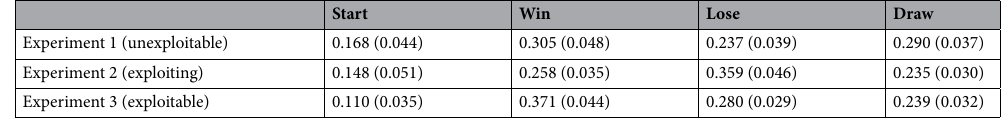
Table 4. Distribution of credits entered as a function of preceding outcome (win, lose, draw) across Experiments 1–3. Standard error in